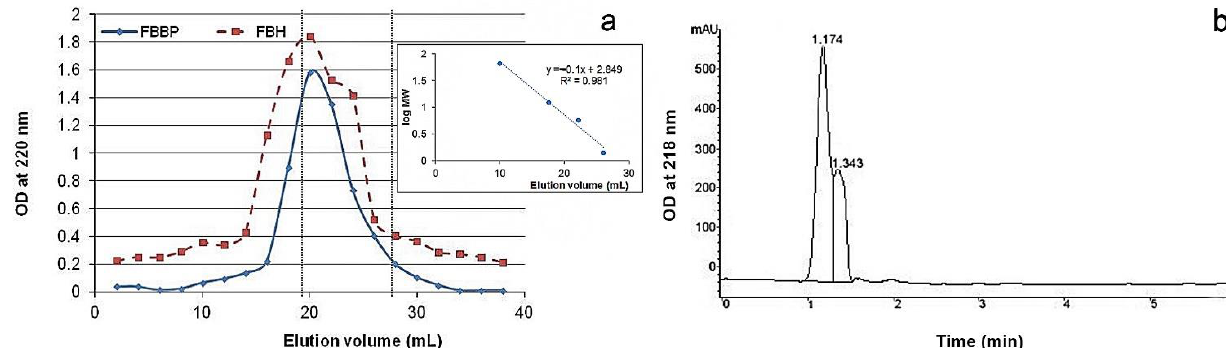
Figure 1. MW distribution of peptides isolated from H. molitrix bones determined by chromatography analyses: ( a ) Size exclusion chromatography of FBH and FBBP filtered preparation on Sephadex G-75. The insert represents the standard curve built using proteins of known MW (albumin, cytochrome c, insulin and bacitracin). ( b ) RP-HPLC of FBBP on Europa C18 peptide column.